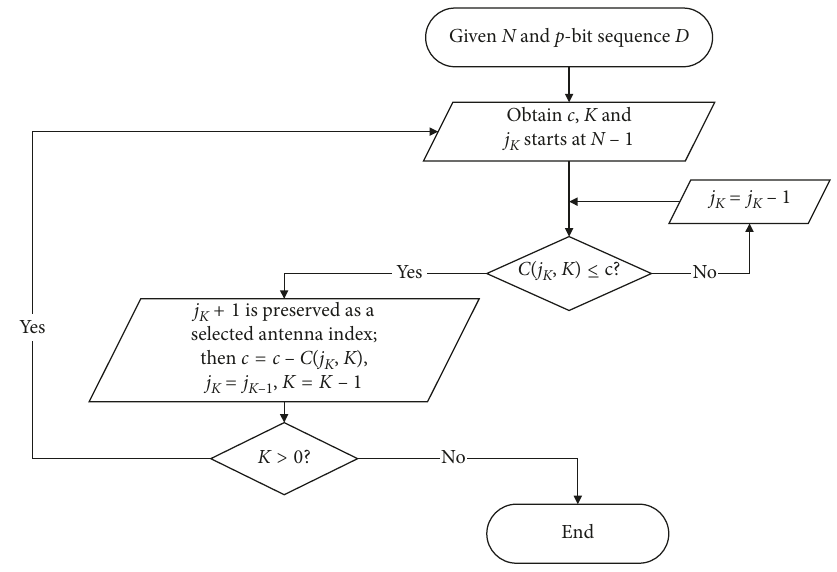
Figure 3: The flow chart of mapping procedures.